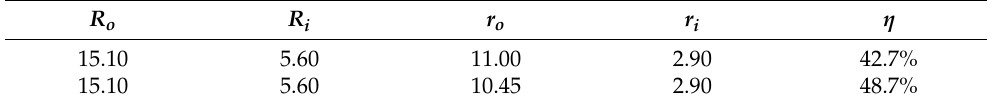
Table 2. The dimensions of the steel tube with different thickness reductions